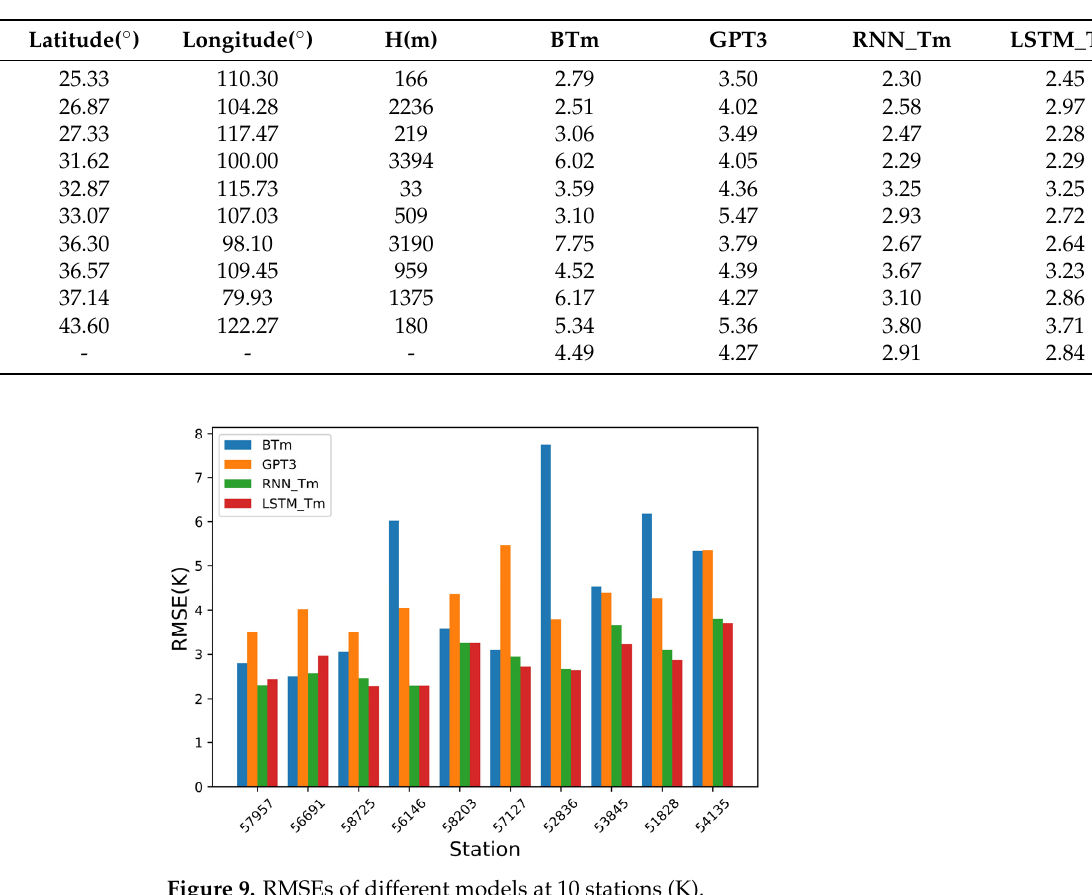
Table 5. RMSE of four models at different stations [K].